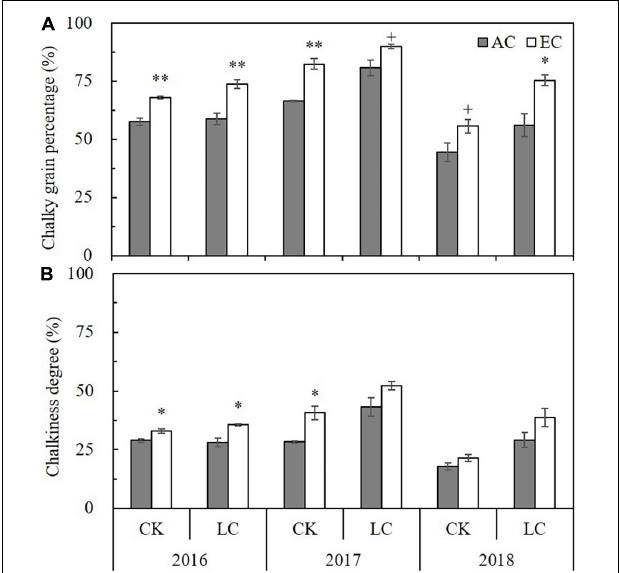
observed in 2016, followed by 2017 and, lastly, 2018 ( Figure 2 ). Compared with ambient CO 2 , eCO 2 reduced amylose concentration by 1.9%, on average, across three growing seasons, and reduced amylose concentration of CK and LC crops by 2.8 and 1.0%, respectively, with CK crops showing a significant difference ( P < 0.1). Compared with CK, LC reduced amylose concentration by an average of 2.5% ( P < 0.1). No significant interactions between year and CO 2 or LC for amylose concentration were observed. The RVA-value represents the viscosity curve and disintegration of starch along with temperature. The values of RVA parameters, except PT and GT, varied significantly among years ( Table 3 ), such that the highest values were observed in 2016, followed by 2017 and, lastly, 2018. Compared with ambient, eCO 2 significantly increased peak viscosity (PV) and minimum viscosity (MV) by 2.9% and 3.8%, respectively, whereas setback (SB) and consistency (CS) significantly decreased by 96.1% and 4.7%, respectively, with no significant effects on breakdown (BD), final viscosity (FV), peak time (PT), or gelatinization temperature (GT). Regarding crops under different source-sink ratios, for CK crops, eCO 2 increased PV, MV, PT, and GT (by less than 3.0%) and decreased SB and CS by 76.7% and 5.2% ( P < 0.1), respectively, on average; for LC crops, eCO 2 increased PV and MV by 4.1% ( P < 0.05) and 4.6% ( P < 0.1), respectively, and decreased SB and CS by 118.9% ( P < 0.01) and 4.1%, respectively. Compared with CK, LC reduced SB and CS by 14.9% and 5.0% ( P < 0.05), respectively, and increased GT